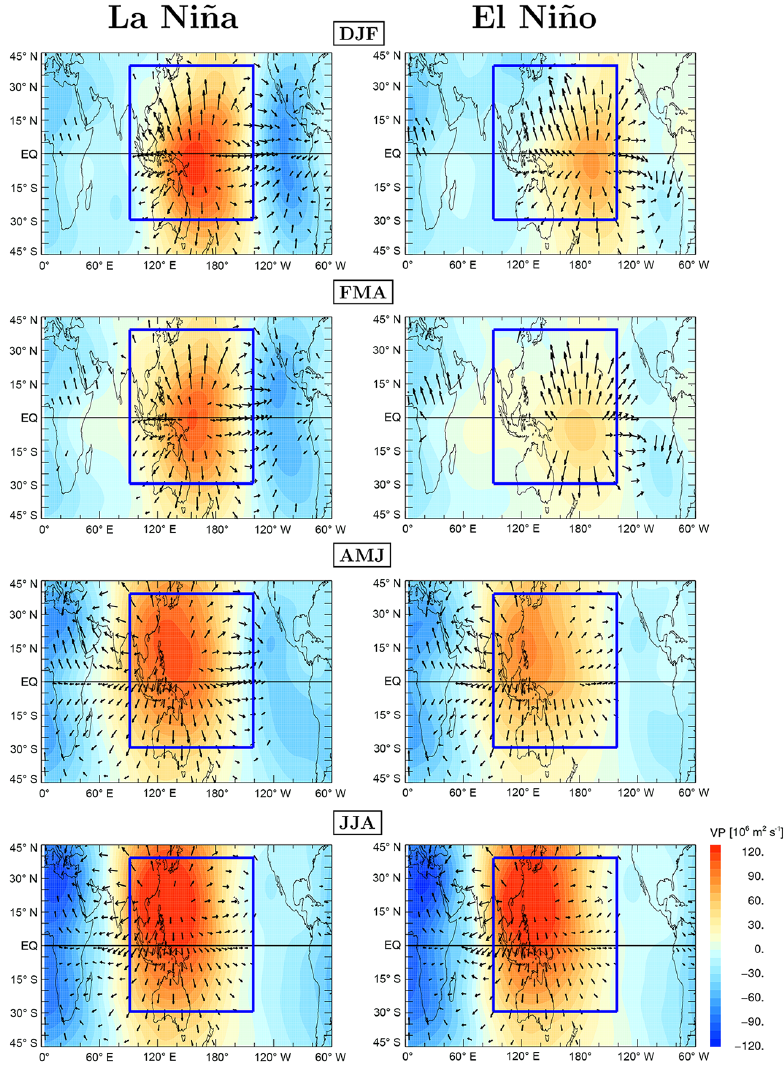
Figure 5. Same as Fig. 2 but for the velocity potential (VP; in 10 5 m 2 s − 1 ) at θ = 380K with arrows denoting the divergent part of the horizontal